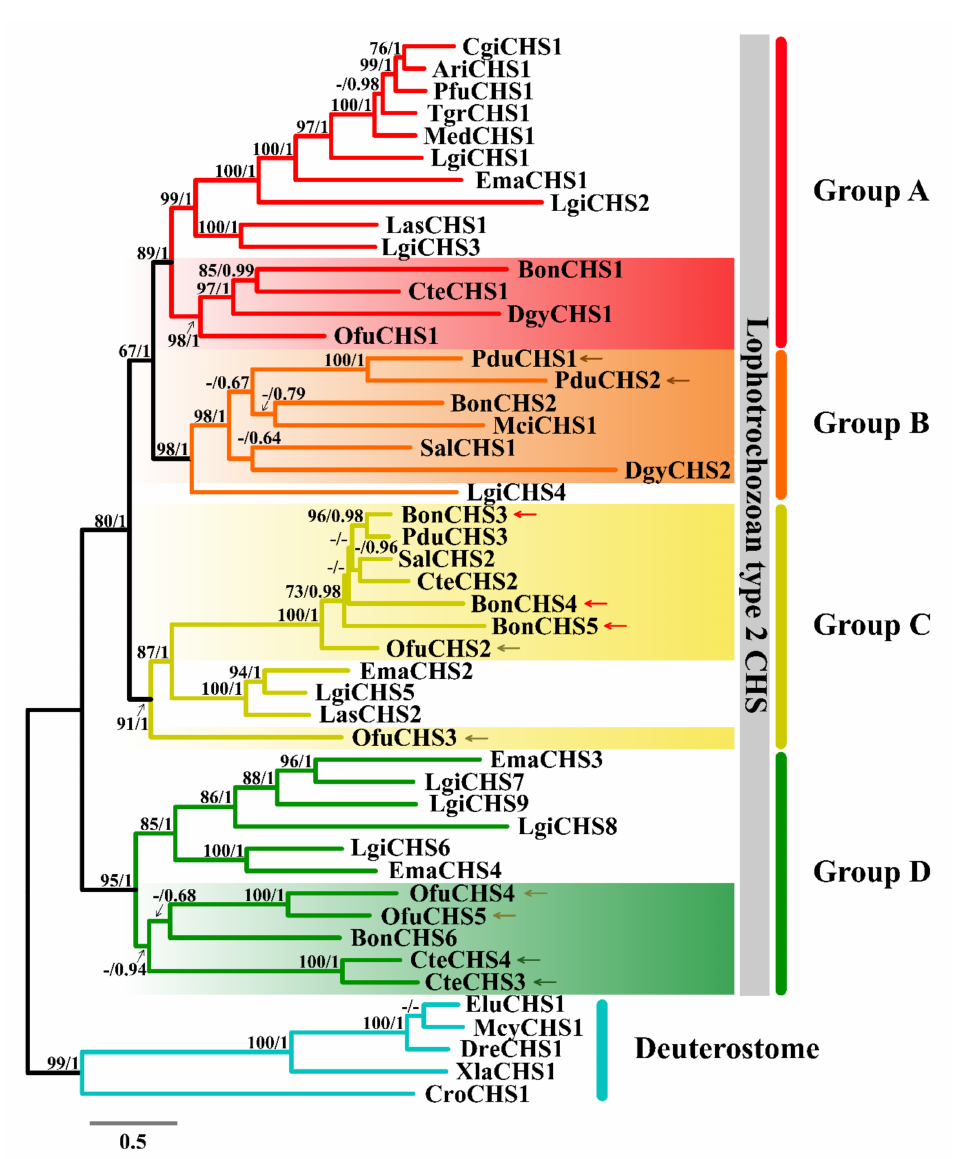
Figure 3. Maximum likelihood phylogeny of chitin synthase genes—48 genes from 15 lophotro- chozoan and five deuterostome species are included. The gene names are abbreviated and listed in Table 1. Genes belonging to the polychaetes are colored in each group (red in group A, orange in group B, yellow in group C, and green in group D). Deuterostome sequences are used as an outgroup. In each node, supporting values for ML and Bayesian inference are shown in this order. The nodes supporting values of <60 are indicated with “-”. The arrows indicate annelids with several copies (orange for Platynereis dumerilii , yellow for Owenia fusiformis , green for Capitellateleta , and red for Branchipolynoe onnuriensis ). The clades with the gradient boxes represent the polychaete species in each group. The scale bar represents the amino acid substitutions per